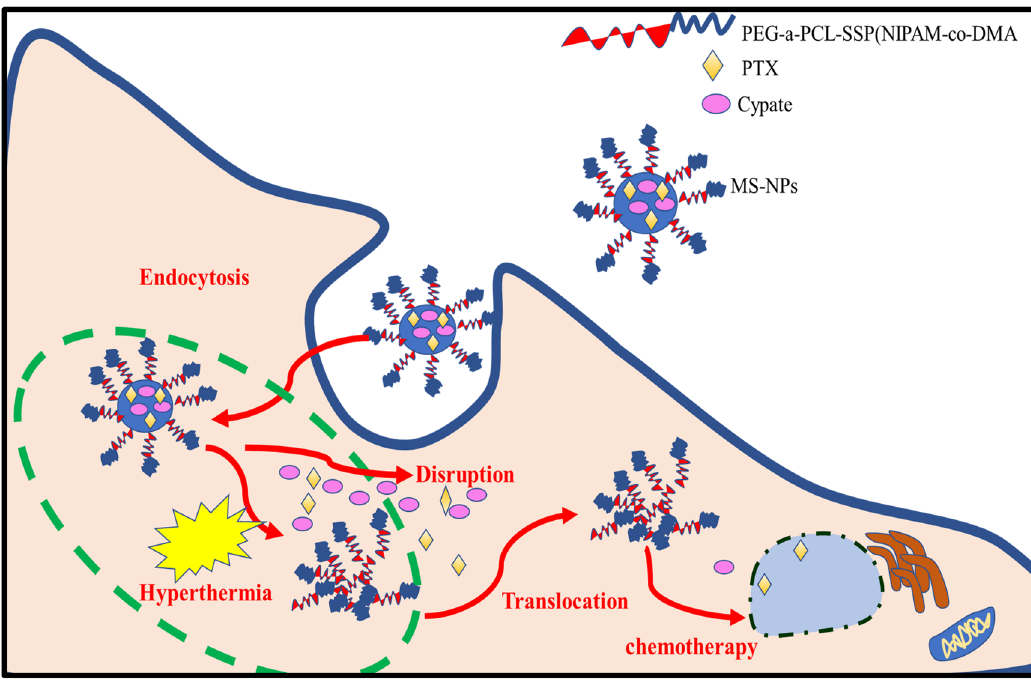
Figure 10: Schematic illustration of multiple stimuli - responsive